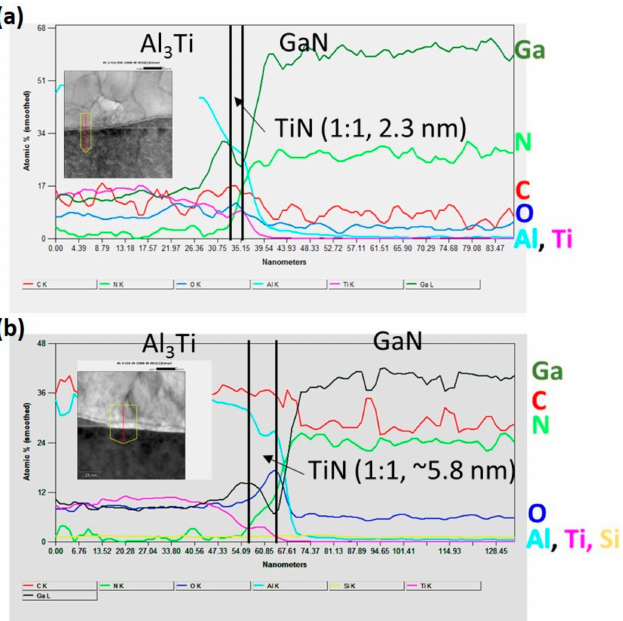
Figure 4. EDS line-scan analysis in the red arrow direction of TEM images for ( a ) Sample A-2 without an a-Si assisted layer and ( b ) Sample B-1 with a 1 nm a-Si-assisted layer. The corresponding TEM images were shown in the